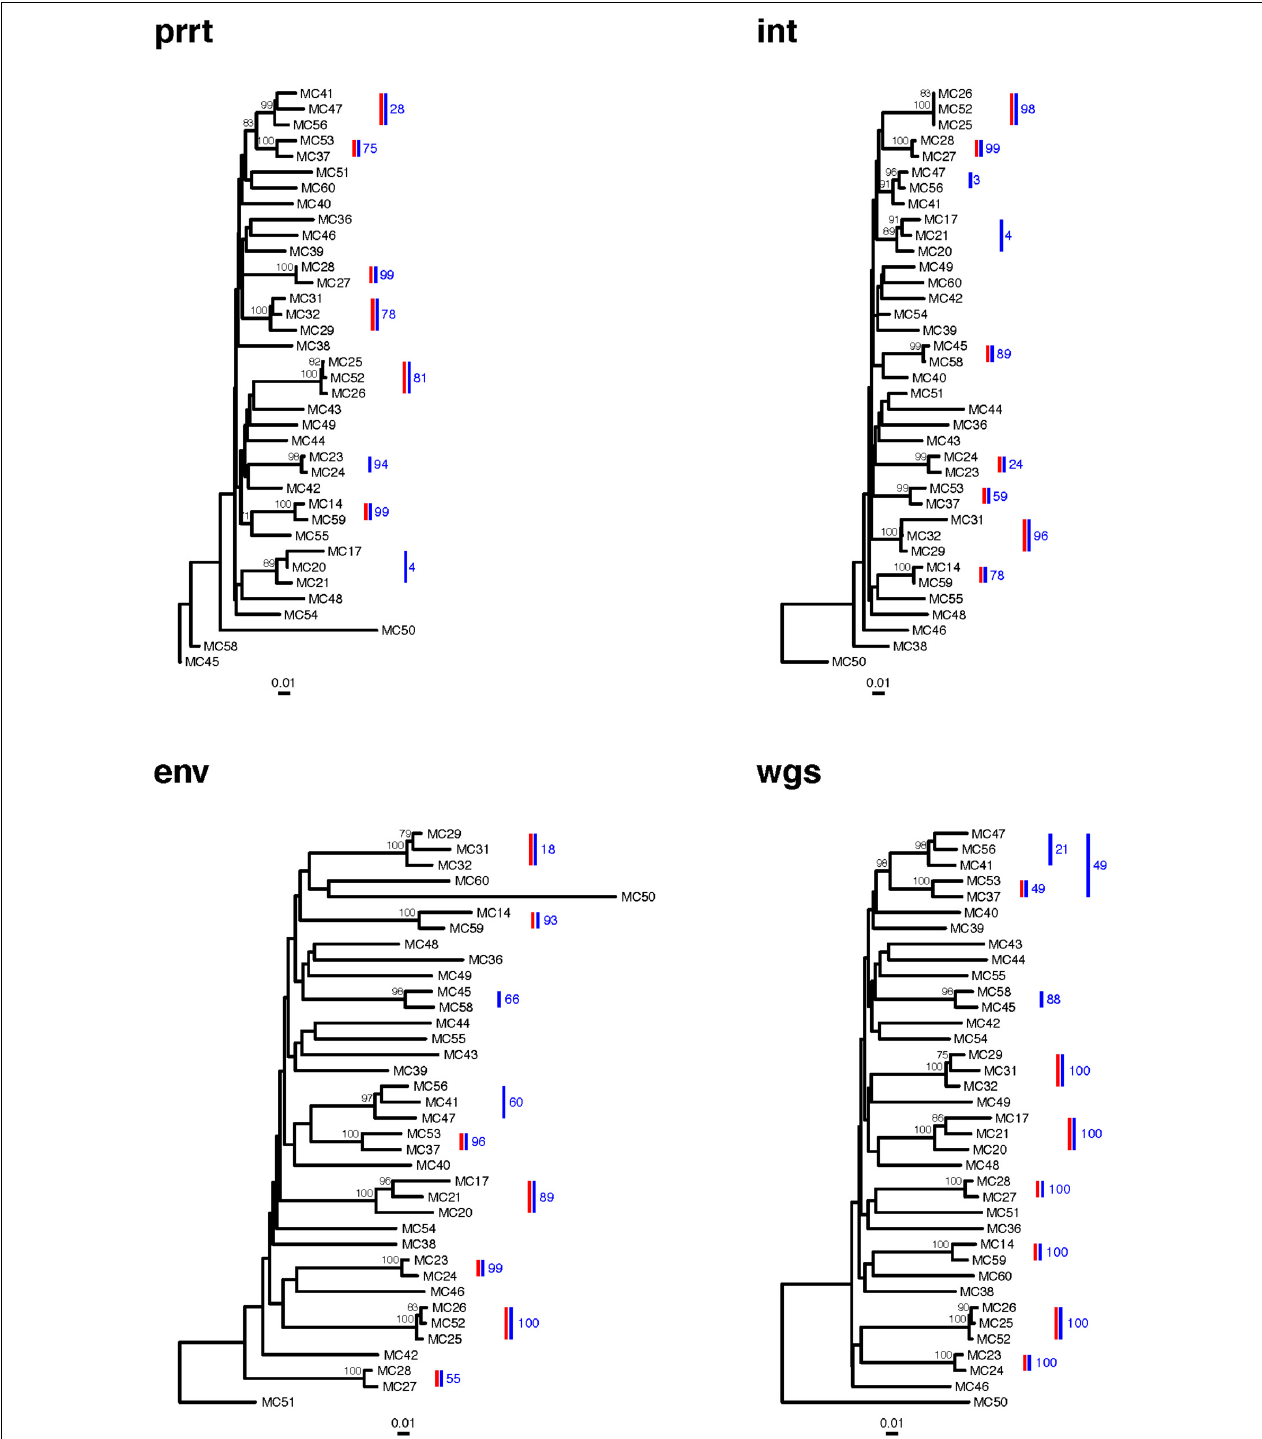
FIGURE 7 | Next-generation sequencing (NGS) consensus sequence phylogenetic trees of 37 new HIV diagnoses in RI according to genomic region. The figure demonstrates clusters in phylogenetic trees from four genomic regions (prrt-protease reverse transcriptase; int-integrase; env-envelope; wgs-whole genome sequence). Clusters ( ≥ 99% bootstrap support) inferred from the phylogenies of NGS consensus sequences (vertical red bars) differ across genomic regions. The largest number of clusters was inferred from int, env, and wgs, and the smallest number from prrt. Profile sampling detected additional clusters (vertical blue bars) and provided a bootstrap-like measure of cluster support (annotation to blue bars). Bootstraps > 70% are shown to the left of the relevant node. Trees are rooted by an HIV-1 group O sequence, which is omitted from the plots.